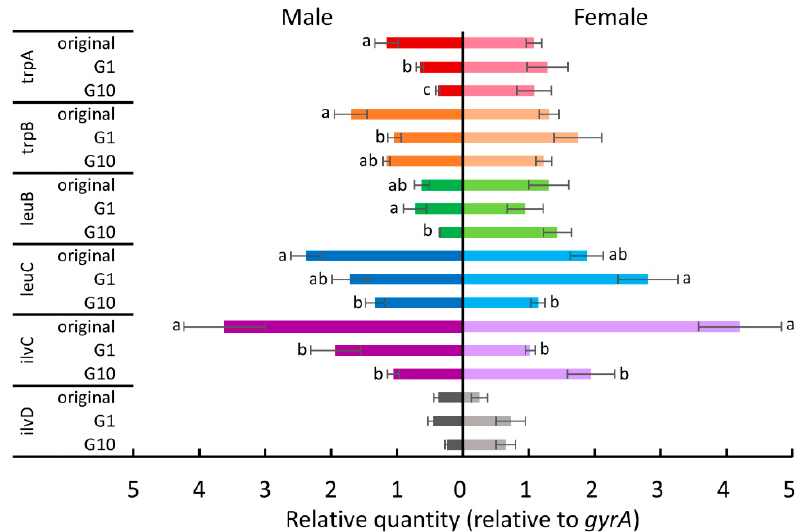
Figure 7. The expression levels of tryptophan, leucine, and isoleucine biosynthesis genes of P. aleyrodidarum in male and female B. tabaci reared on tomato plants in the first and the tenth generations. Expression levels in the original colony are also shown. Horizontal bars indicate standard errors. Different letters indicate significant differences (Tukey test, p < 0.05).